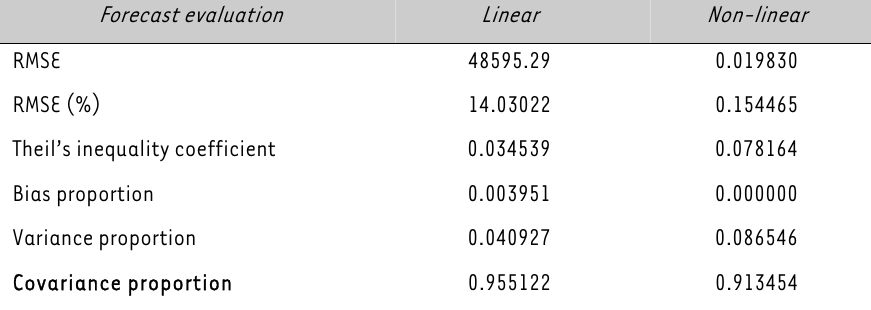
TABLE 9: Comparison of forecast evaluation CREDIT Forecast